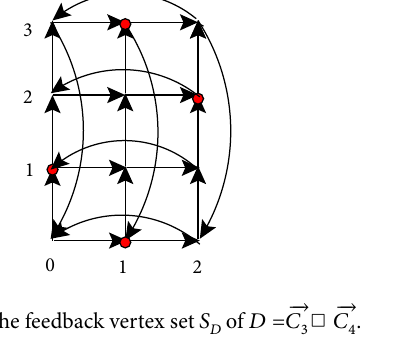
Figure 2: The feedback vertex set 𝑆